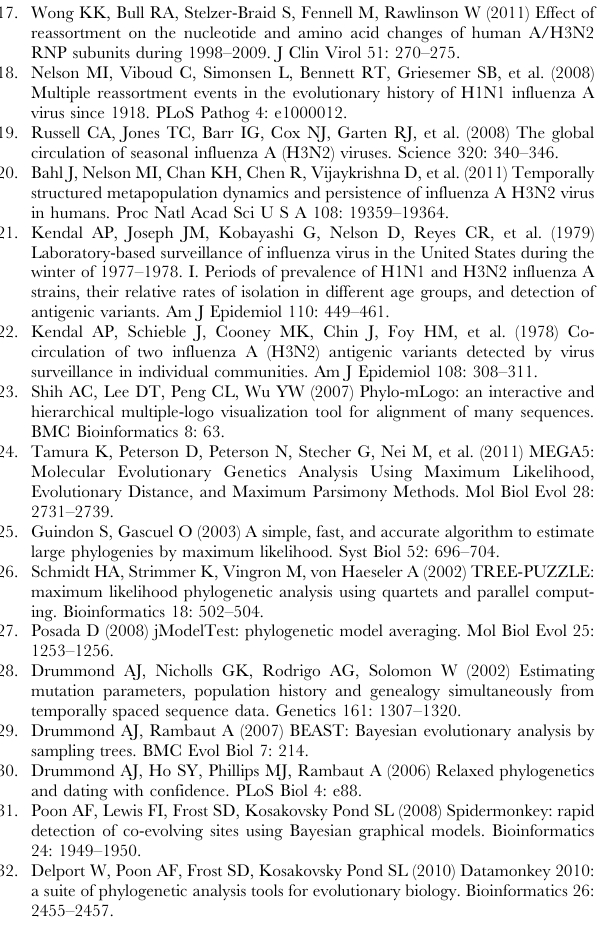
A (H1N1) virus is not included. Different types and subtypes were colored as follow: H1N1 in blue, H3N2 in red, B in green. (TIF) Figure S2 Phylogenetic relationships of the internal gene segments of influenza A virus in Taiwan. Phylogenetic relation- ships of the (A) PB2 gene segment (B) PB1 gene segment (C) PA gene segment (D) NP gene segment (E) M gene segment and (F) NS gene segment of H1N1 and H3N2 influenza viruses sampled from Taiwan during 1980–2009, estimated using ML method. Labeling, color schemes, and rooting are same as in Figure 1.